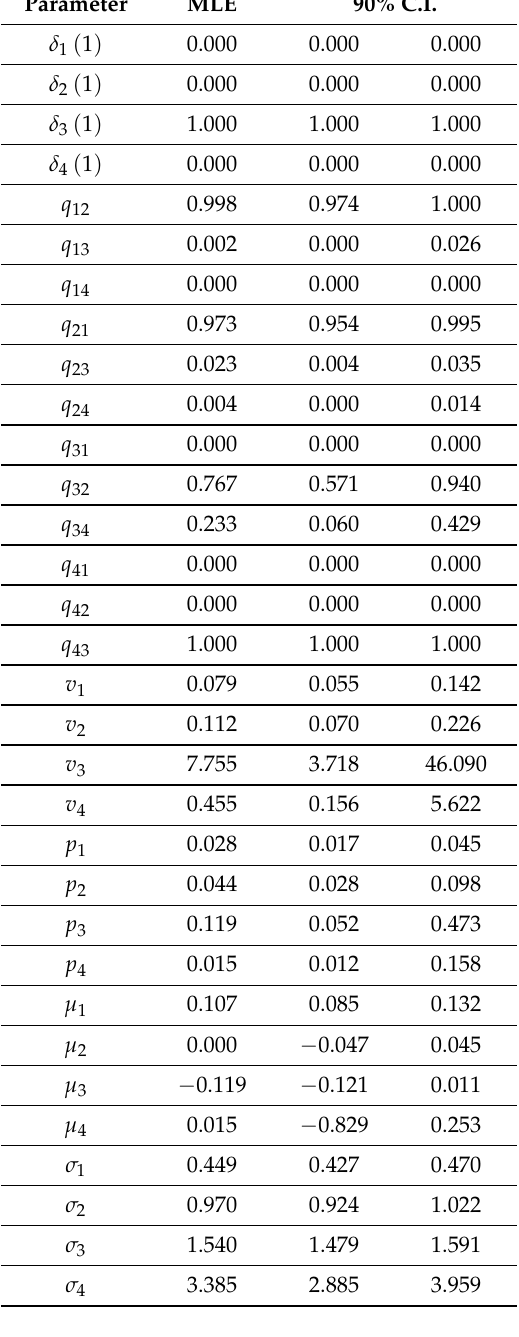
Table 6. Parameter estimates and parametric bootstrap confidence intervals for the homogeneous four-state HSMM based on the complete S and P 500 log returns